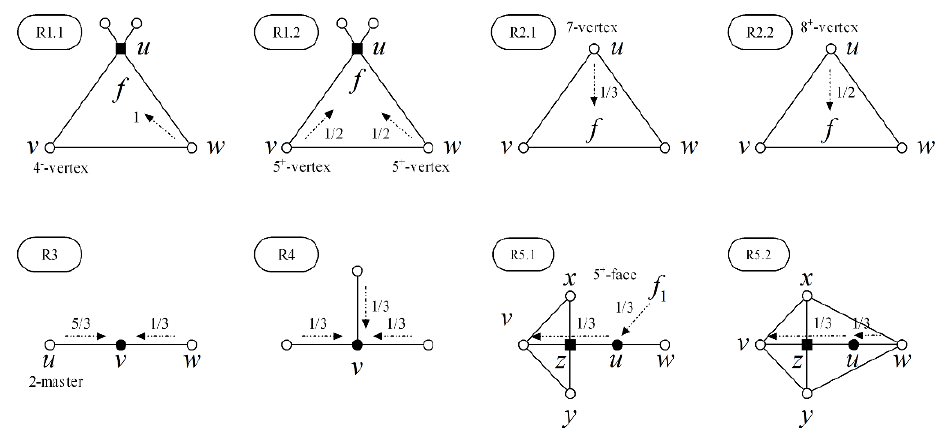
Figure 3. Discharging rules for the proof of Theorem